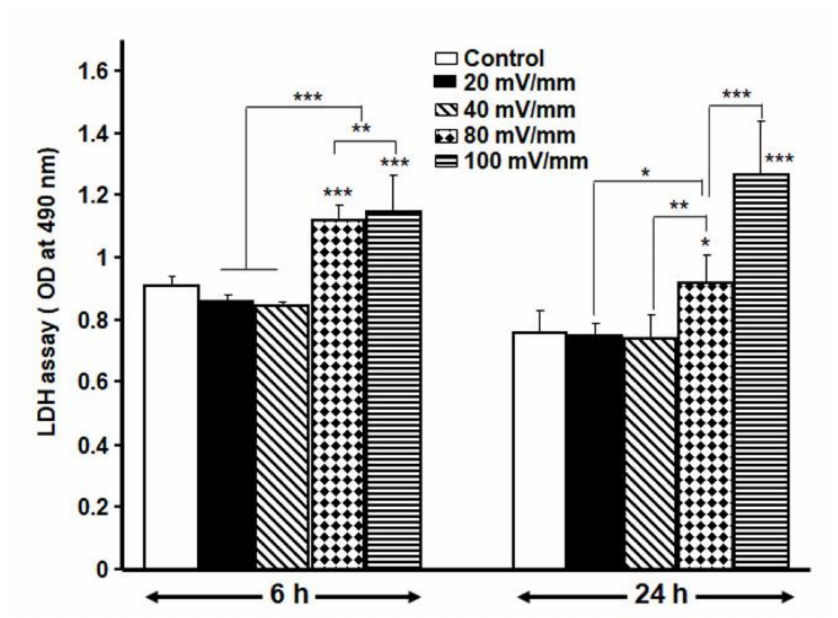
Figure 4. LDH activity of DHSF exposed to different intensities of ES. Data are presented as means ± SD ( n = 4). * p < 0.05, ** p < 0.01, *** p < 0.001. The control (no ES) and ES-exposed cells were compared, as well as the different ES